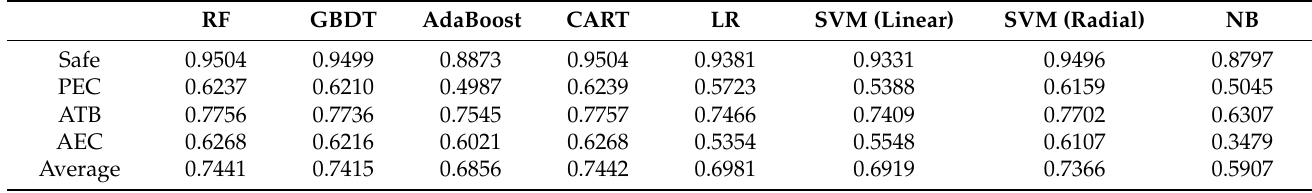
Figure 5. Venn diagram of generated rules per class. Table 3. F1-score before feature